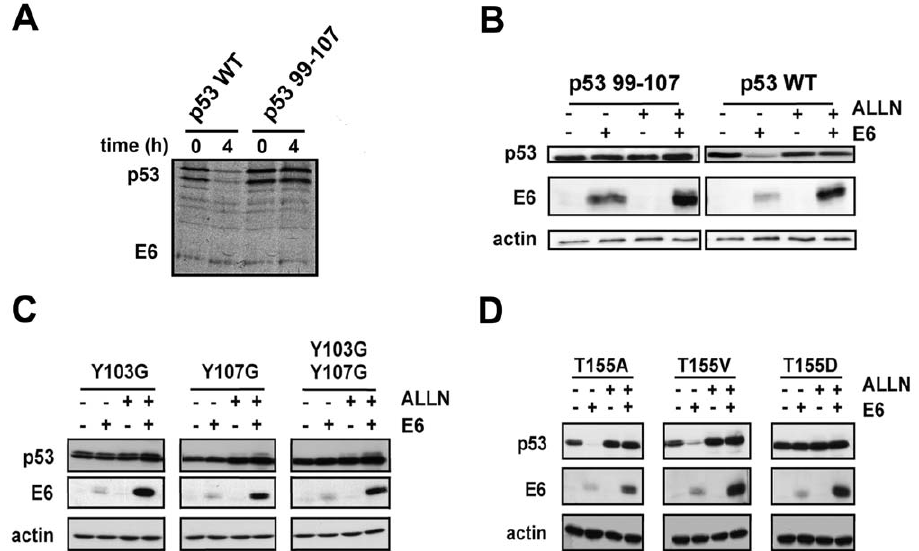
Figure 3. Behaviour of p53 mutants in presence of E6. (A) Radiolabeled p53 (wild type and indicated mutants) and HPV16 E6 proteins produced in rabbit reticulocyte lysates were incubated together at 28 u C. Aliquots were removed at the indicated times before separation by 12% SDS-PAGE and exposition to photographic film. (B, C and D) H1299 cells were co-transfected by vectors for transient expression of HPV16 E6 and p53 proteins. Where indicated, 4 h prior to harvesting, the medium was supplemented with the 26S proteasome inhibitor ALLN at a final concentration of 100 m M. 24 h after transfection, extracted proteins were separated by 12% SDS-PAGE and analysed by Western-blotting using monoclonal anti-p53 antibody, polyclonal anti-actin antibody and monoclonal anti-16-E6 antibody.